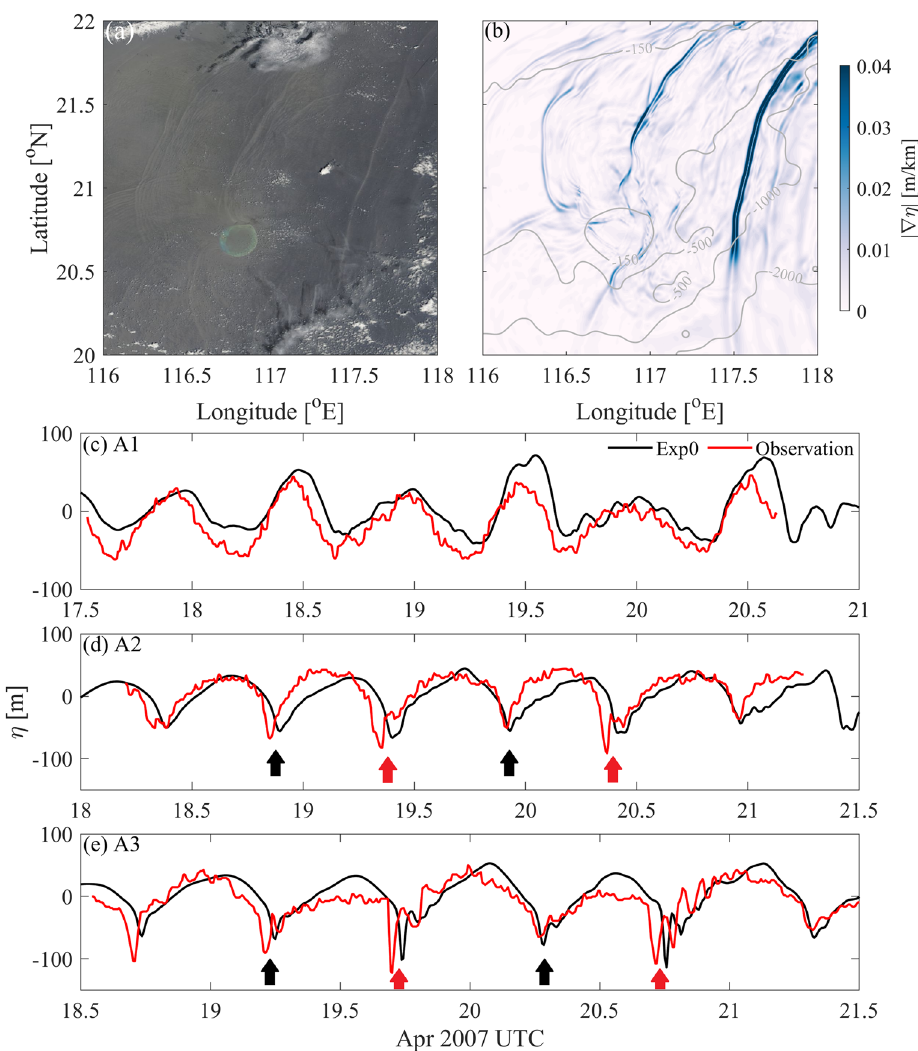
Figure 2. ( a ) MODIS image at 03:00:00 April 20, 2007, UTC. ( b ) The gradient of the sea surface height (shading, unit: m/km) in Exp0 at 03:00:00 April 20, 2007, UTC. Grey contours in the subfigures denote the isobaths Comparisons between observations3 and model results of Exp0 at ( c ) A1, ( d ) A2 and ( e ) A3. In ( d,e ), the red and black arrows indicate the A-waves and B-waves,